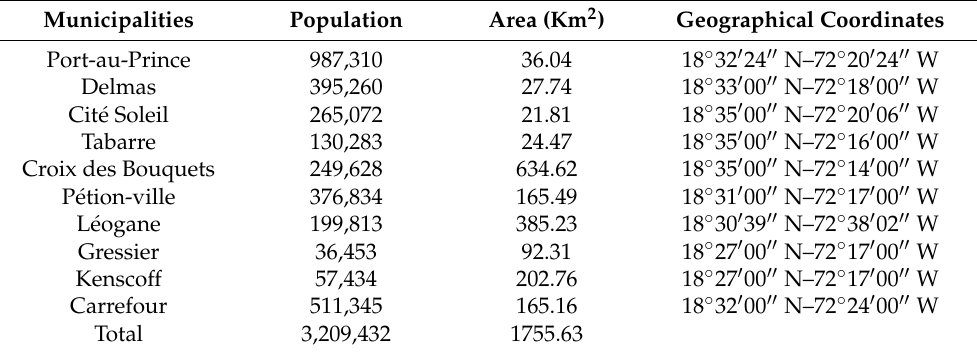
Table 1. Population, area and geographic coordinates of the municipalities in the Port-au-Prince agglomeration